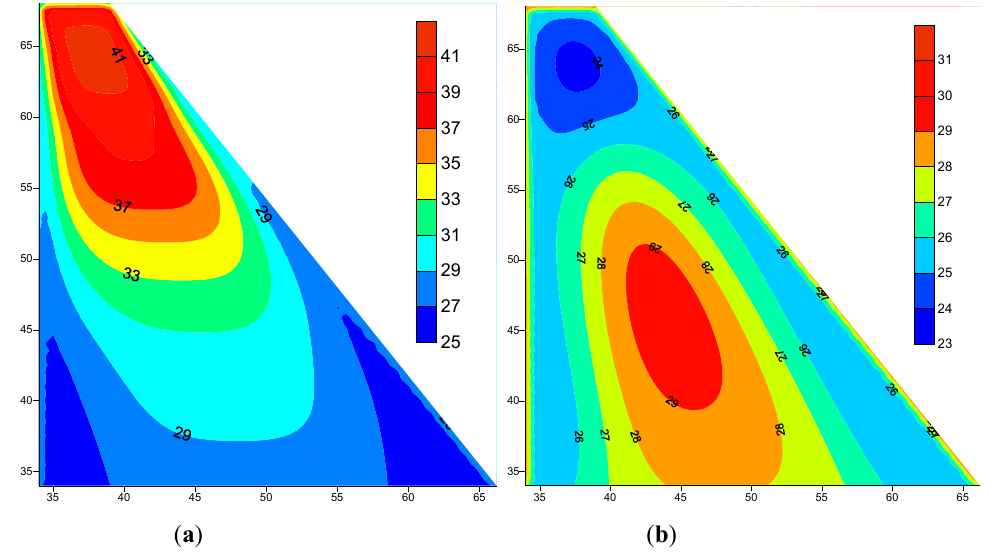
Figure 5. Dam body temperatures distributions ( °C ): ( a ) immediately after construction and ( b ) after one year of construction.